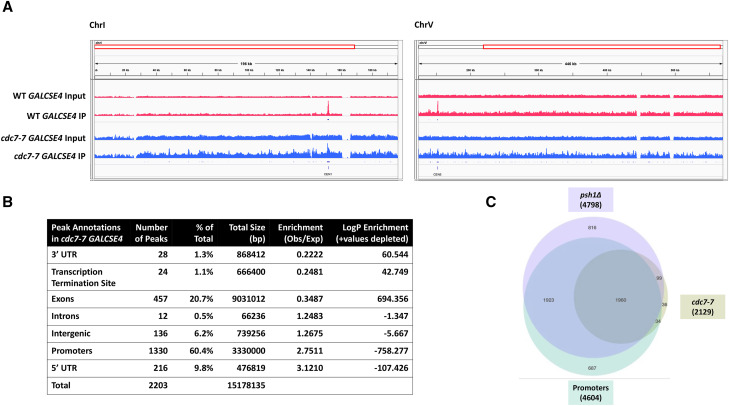
Cse4 is mislocalized to non-centromeric regions in a cdc7-7 strain. ChIP-seq was performed using chromatin lysates from wild type (YMB10044) and cdc7-7 (YMB10041) strains. A. Flag-Cse4 is mislocalized in a cdc7-7 strain. Genome browser of input and ChIP samples for Chromosome I and Chromosome V in wild type (top) and cdc7-7 (bottom) strains overexpressing Flag-Cse4. Regions of CEN1 and CEN5 are shown. B. Flag-Cse4 is enriched at promoters in a cdc7-7 strain. The annotatePeaks tool of HOMER v5.10 (http://homer.ucsd.edu/homer/) was used to define genomic locations of Flag-Cse4 enrichment in the cdc7-7 strain. The genomic feature, peak number, percent of total peaks, region size, fold-enrichment (relative to sequence content), and LogP enrichment are indicated. C. FLAG-Cse4 is preferentially enriched at promoters in cdc7-7 and psh1Δ strains. Overlap between Flag-Cse4 enrichment in cdc7-7 and psh1Δ strains and at promoters.